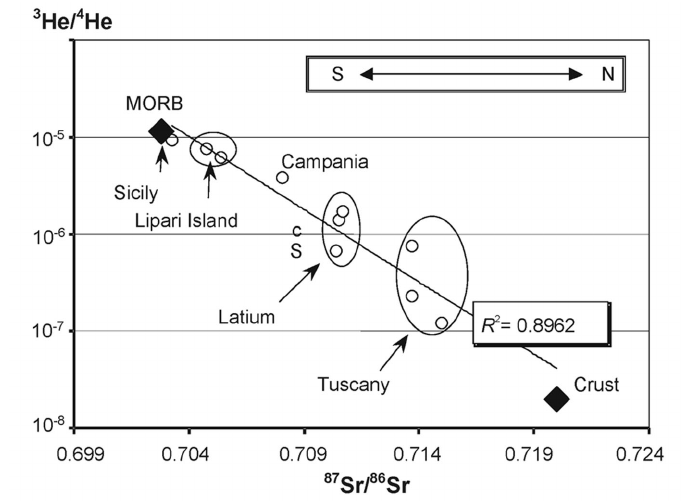
Fig. 4. 3 He/ 4 He- 87 Sr/ 86 Sr dependence in the products of volcanic and hydrothermal activity in Italy (Polyak et al. ,